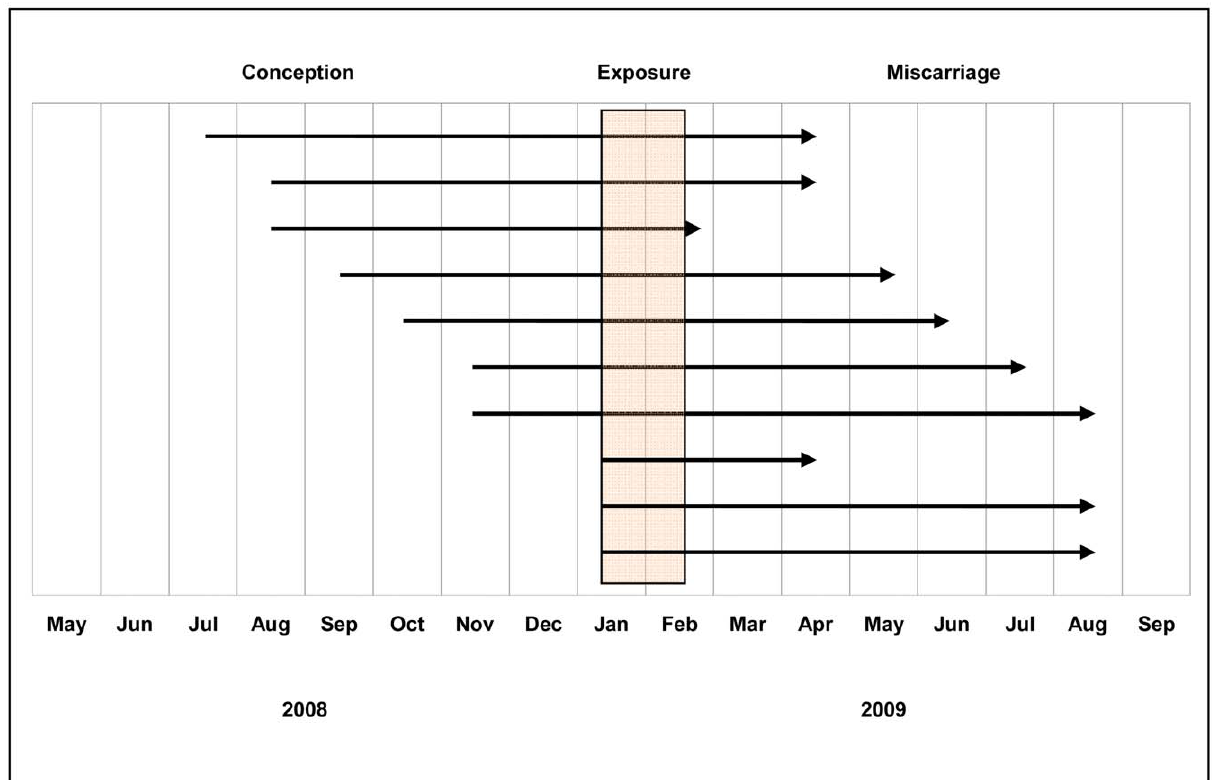
Figure 2. Timing of vaccine exposure during pregnancy of the 10 miscarriages.